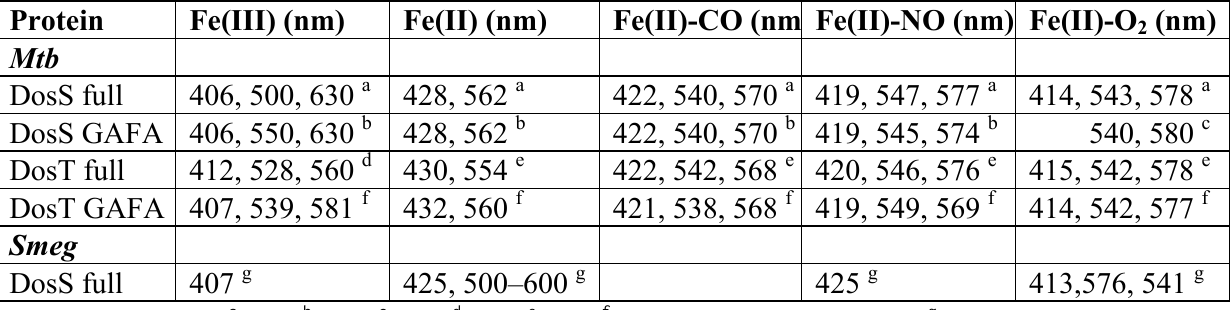
Table 2. Representative UV-vis maxima for the DosS and DosT constructs from Mtb and M. smegmatis